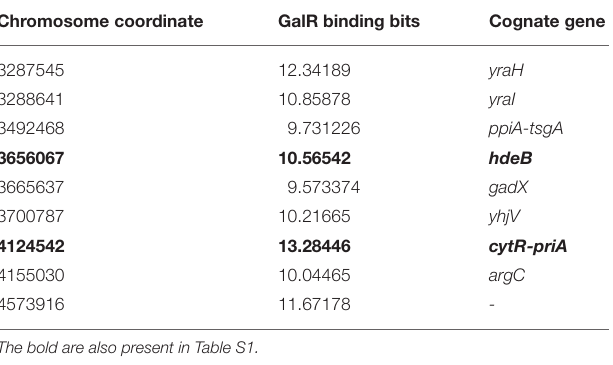
TABLE 2 | GalR binding sites predicted by information theory.